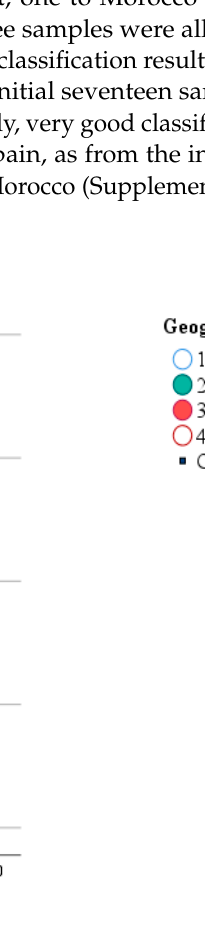
Figure 3. Discrimination of citrus honey geographical origin based on volatile compounds and LDA.